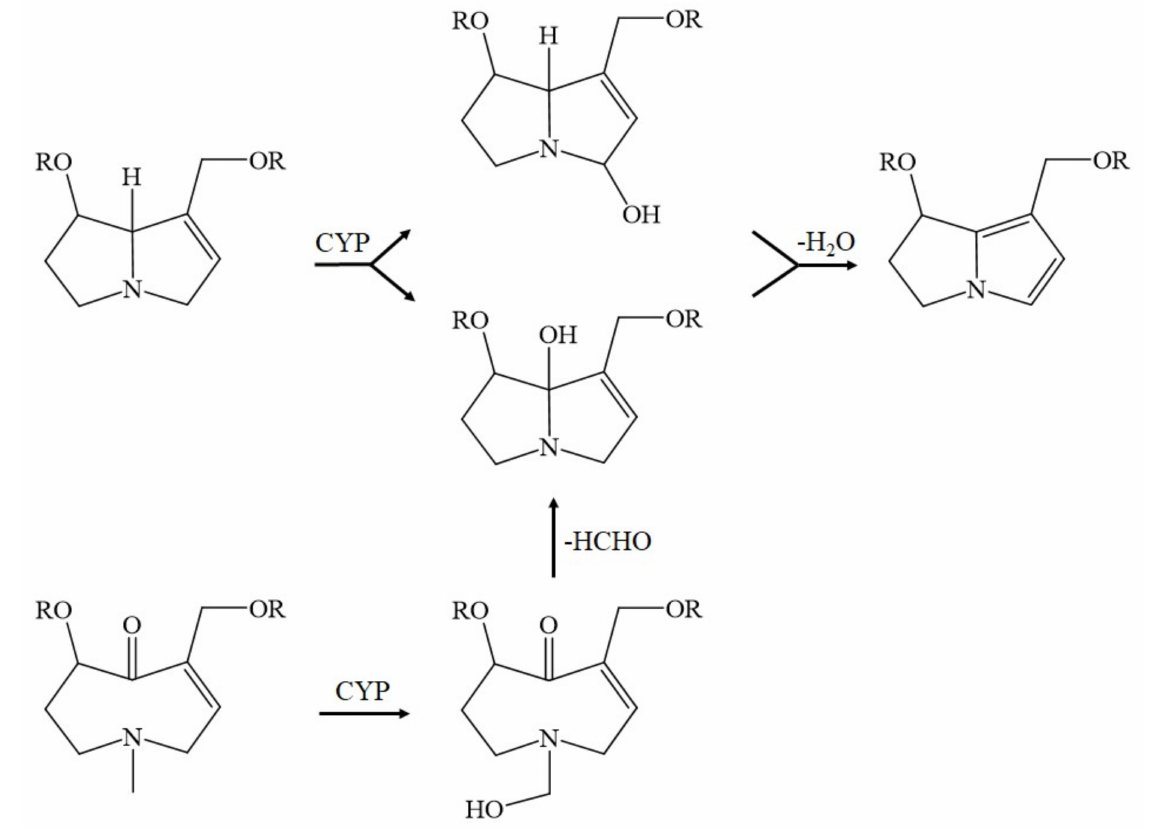
Figure 8. Interactions of CYP with some unsaturated PA forms. CYP modifies the chemical structure of some 1,2-unsaturated PAs, leading to the removal of their specific unsaturation between C1 and C2. Abbreviations: CYP, cytochrome P450; PA, pyrrolizidine alkaloid. The figure was taken from the open access report of Schramm et al.